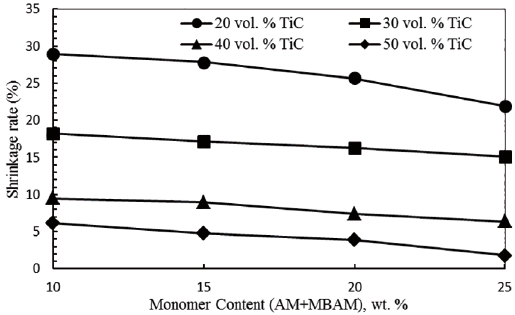
Figure 12: The influences of monomer content and solid loading on shrinkage rate of TiC green